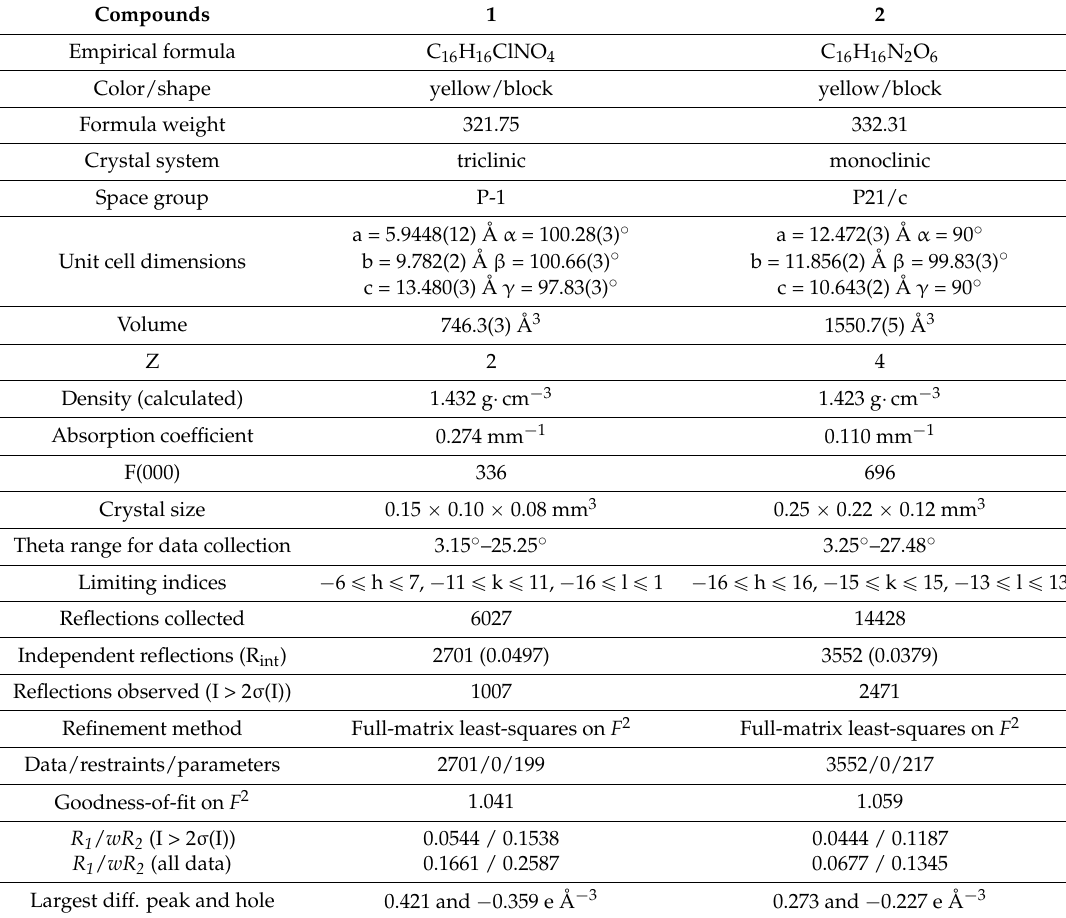
Table 3. Selected crystal data and details of the structure determination for the two